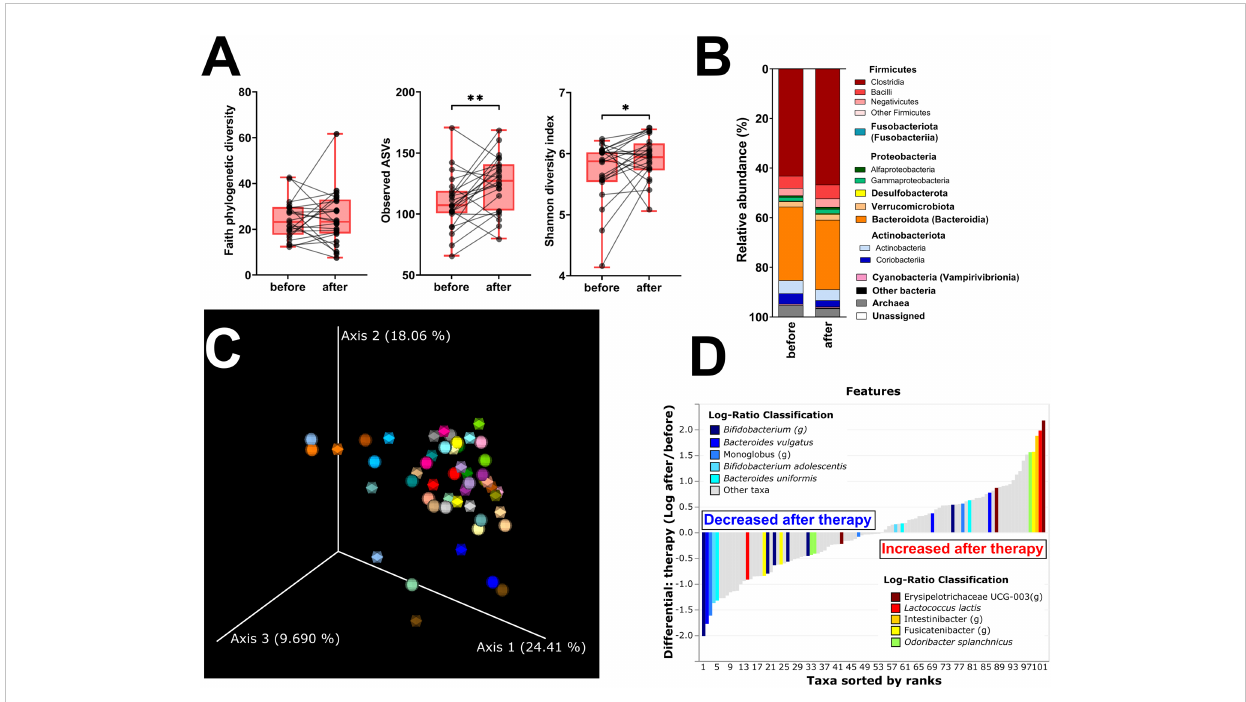
FIGURE 3 Hormonal treatment increases bacterial a -diversity and induces small but measurable shifts in b -diversity. (A) Changes in a -diversity after 12 months of hormonal therapy were characterized by the metrics Faith ’ s phylogenetic diversity, observed features, and Shannon diversity index. (B) b -Diversity comparison at the class level. (C) Principal coordinate analysis (PCoA) plot using the weighted UniFrac distance metric shows the fecal microbiota compositional differences induced by hormonal therapy. The time point before therapy is shown as a sphere and the time point after 12 months of hormonal therapy as an icosahedron. The same color represents the same patient. (D) Differential rankings of taxa associated with the patient ’ s status related to surgery with ranks estimated from multinomial regression with the top 5 species/genera related to each state highlighted. For a - diversity analyses, rarefaction was performed at 2,020 reads, and patients with lower yields in one time point were excluded from the analysis. Groups were compared with the Wilcoxon matched-pairs signed rank test or paired t -test (A) . * p < 0.05; ** p < 0.01. Comparison of all clinical data for these patients is found in Table